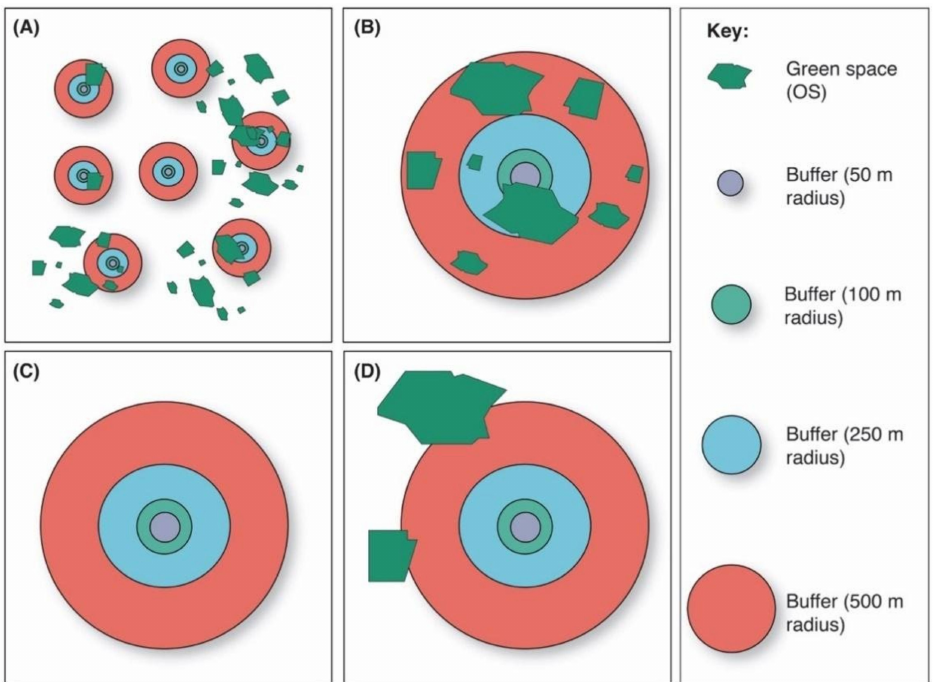
Figure 1. Buffer types and green space polygons used in this study. Green space shapefiles (green polygons) were imported into QGIS and buffer radii of 50, 100, 250, and 500 m were created. ( A ) shows an example where green space presence/abundance differs between buffer zones; ( B ) shows buffer zones with several green spaces within; ( C ) shows a buffer without any green spaces; and ( D ) provides an example of where green space polygons are touching the 500 m buffer but are not completely encapsulated—these would still be counted as being within this buffer